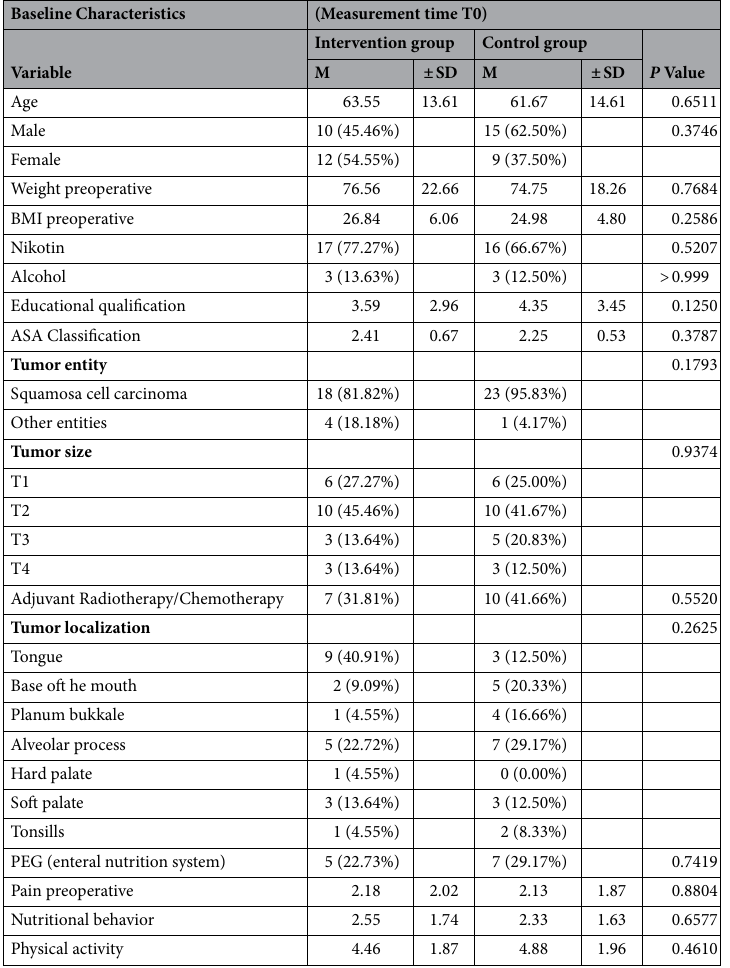
Table 1. Baseline characteristics. M = mean, SD = standard deviation, PEG = percutaneous endoscopic gastroscopy.